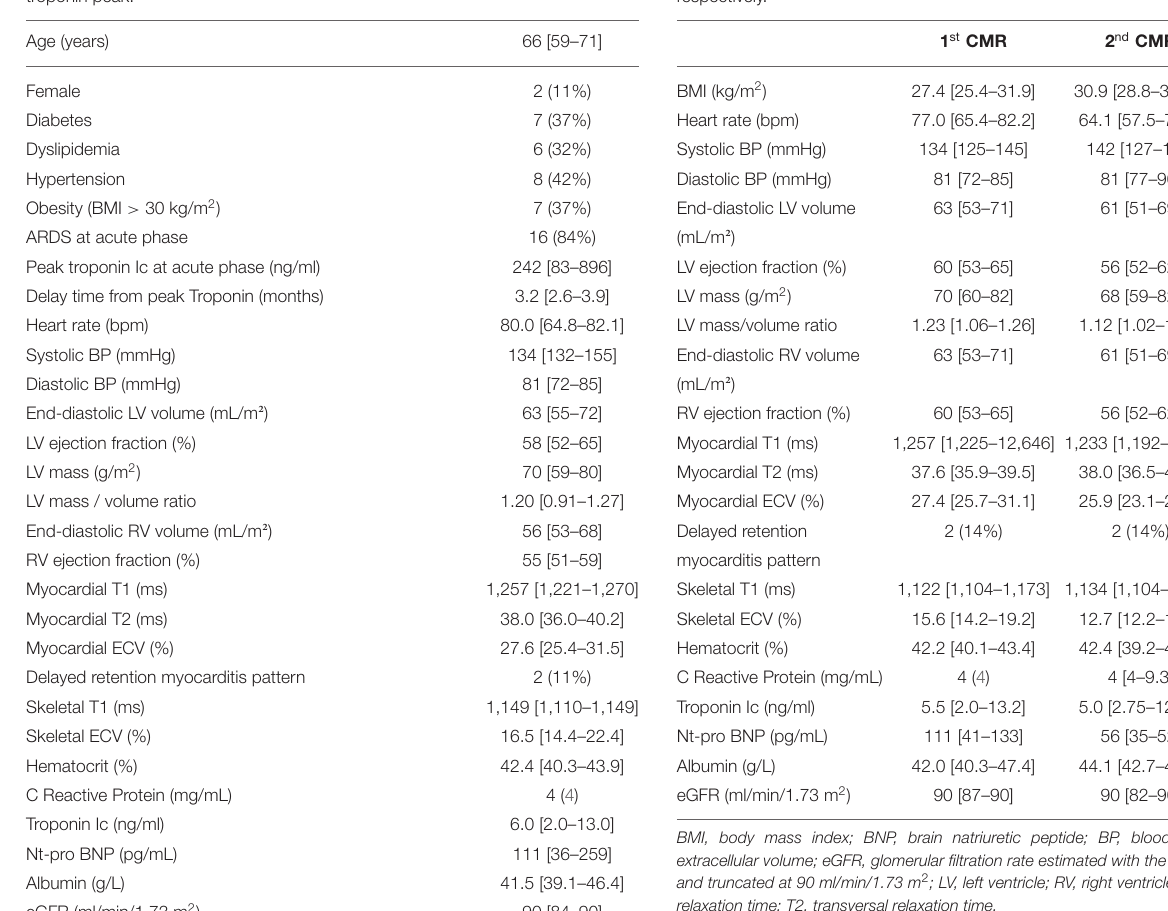
TABLE 2 | Main characteristics of the 19 patients with blood, clinical and CMR data collected on the day of the 1 st CMR, at a median of 3.2 months from the troponin peak.